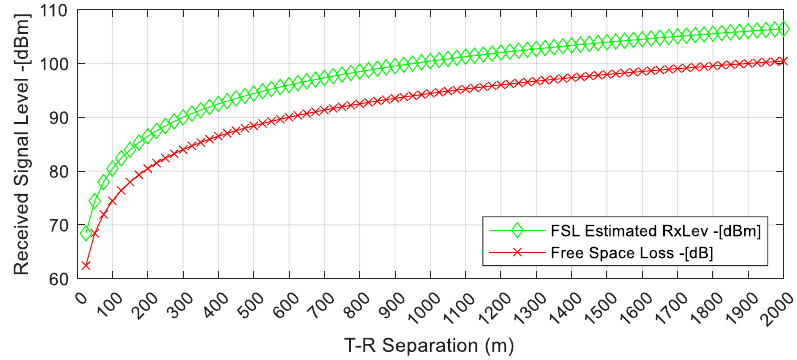
Fig. 9 FSL as a function of distance (carrier Frequency